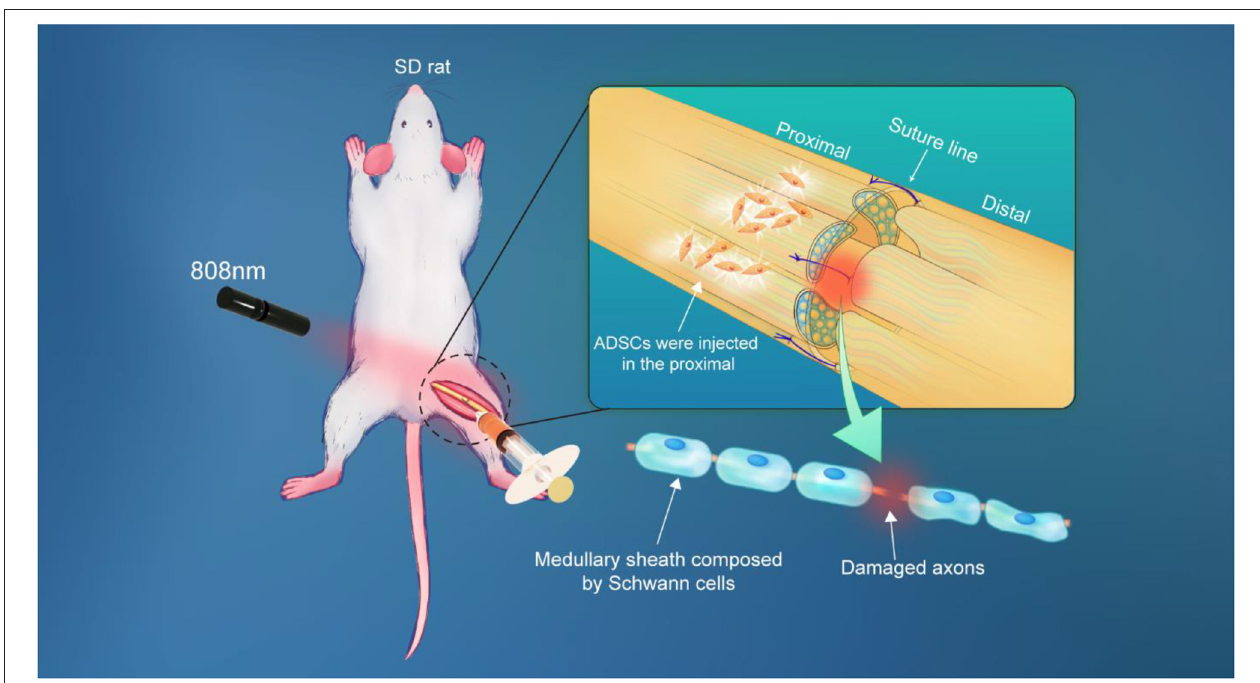
FIGURE 1 | Schematic of the experimental